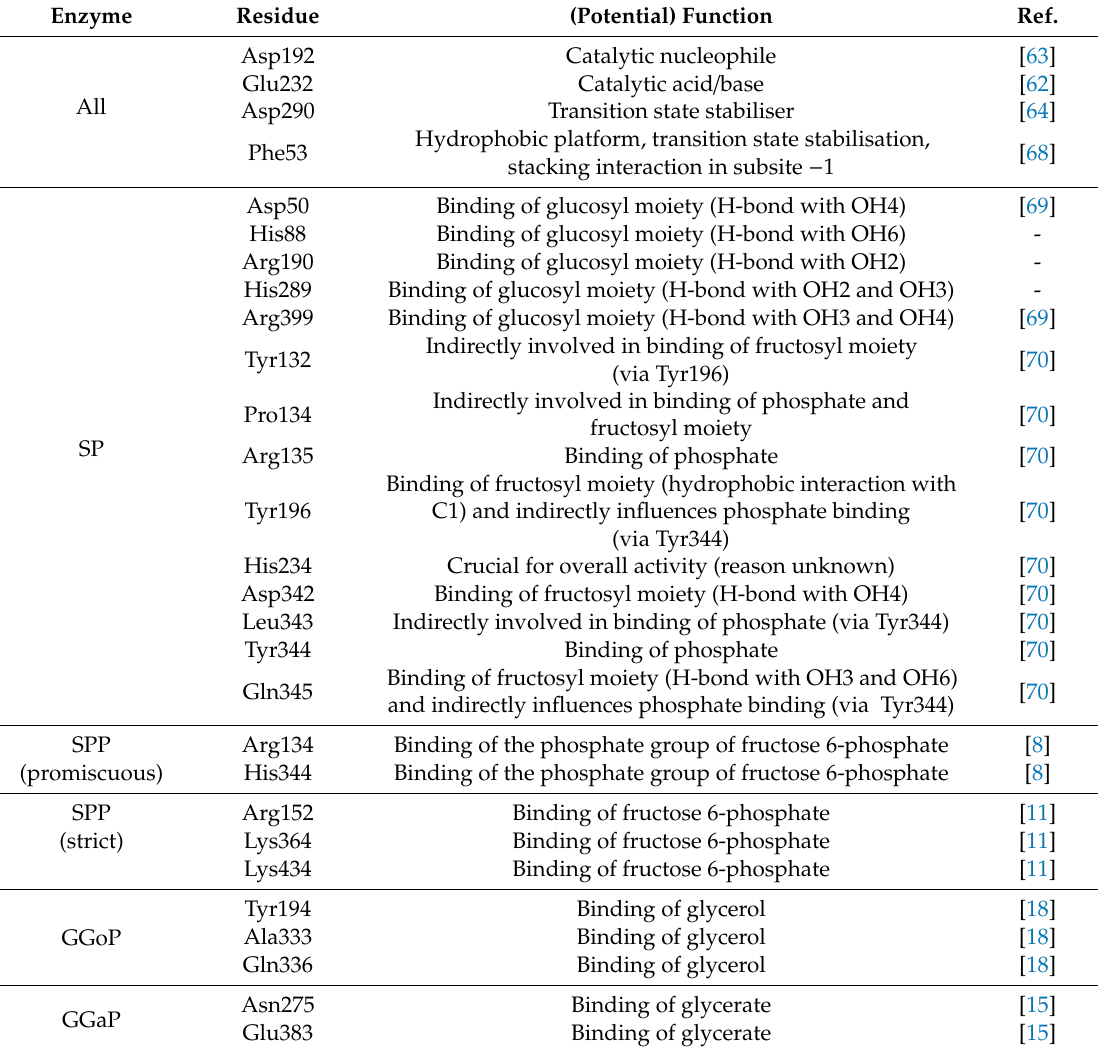
Table 2. Function of residues in GH13_18 phosphorylases. Residue numbers are from the sequence of B. adolescentis SP (also for catalytic residues), T. thermosaccharolyticum promiscuous SPP, I. coccineus strict SPP, M. adhaerens GGoP or M. silvanus GGaP. When no reference is given, the potential function was derived from the crystal structure of BaSP (PDB code